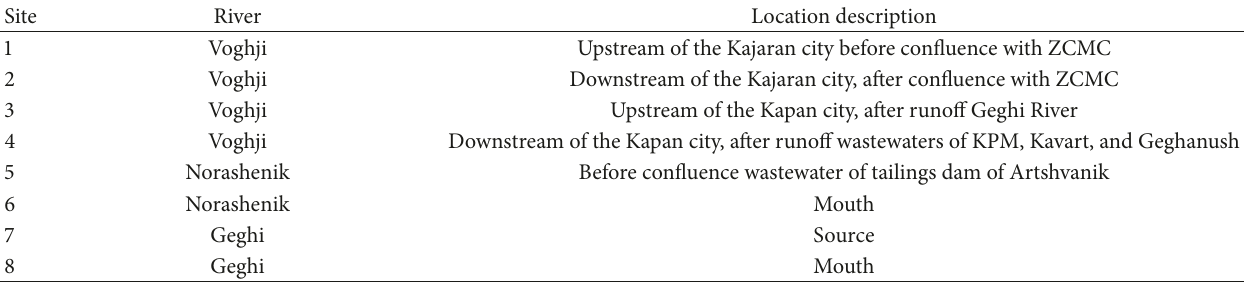
Table 1: Summary of sampling sites (water and sediment) of the Voghji River